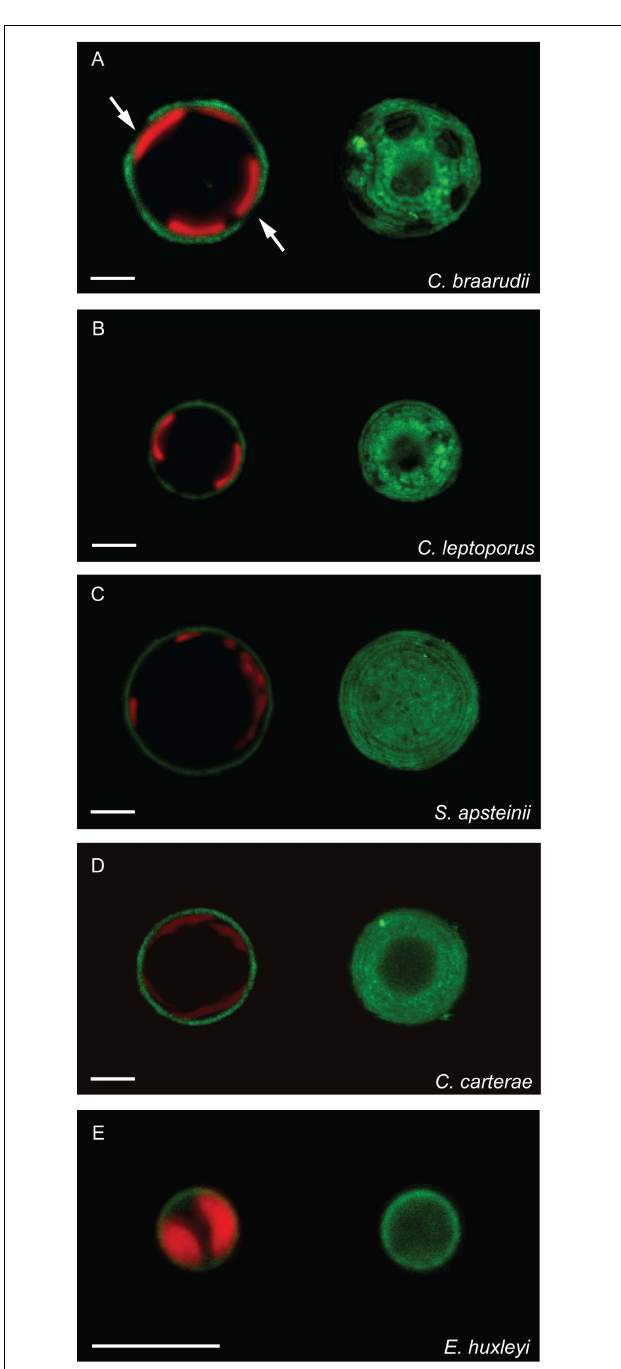
FIGURE 2 | A polysaccharide layer on the cell surface of decalcified coccolithophores. Confocal microscopy imaging of decalcified coccolithophores stained with the fluorescent lectin FITC-ConA (green). Chlorophyll autofluorescence is also shown (red). The staining revealed a layer of polysaccharide on the cell surface of all five species. An individual confocal image (left) and a 3D reconstruction from a Z-stack (right) are shown for each species. (A) C. braarudii exhibits regular ellipsoidal intervals in the FITC-ConA staining. (B) C. leptoporus shows some irregularities in the FITC-ConA staining, (C–E) all other species have a smooth consistent layer. Scale bars represent 5 µ m.